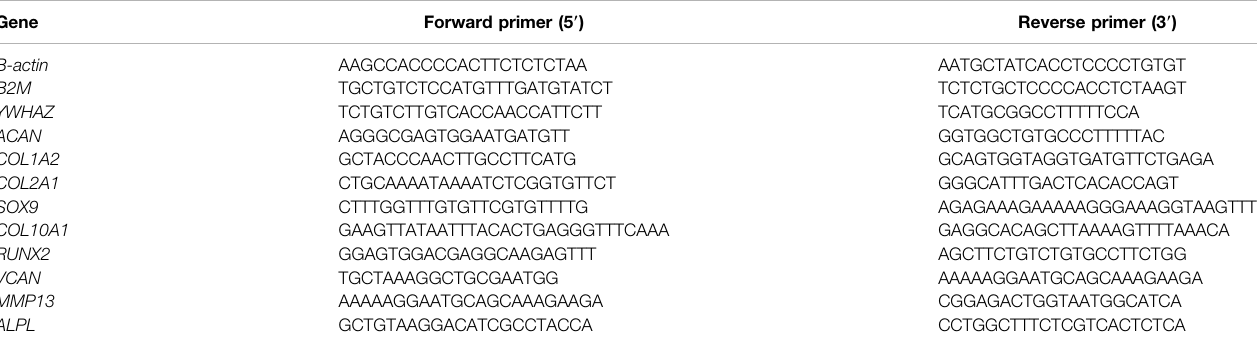
TABLE 3 | Primer sequences for quantitative real-time polymerase chain reaction.